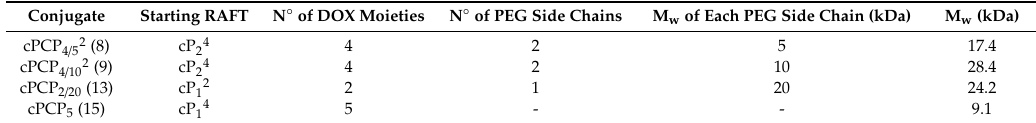
Table 1. Properties of DOX-containing RAFT conjugates: final name, starting RAFT basis, number of DOX and PEG moieties attached and molecular weight are presented. (Generic name cPCP a / bc where a = number of DOX, b = MW of PEG x 1000 and c = number of PEG).